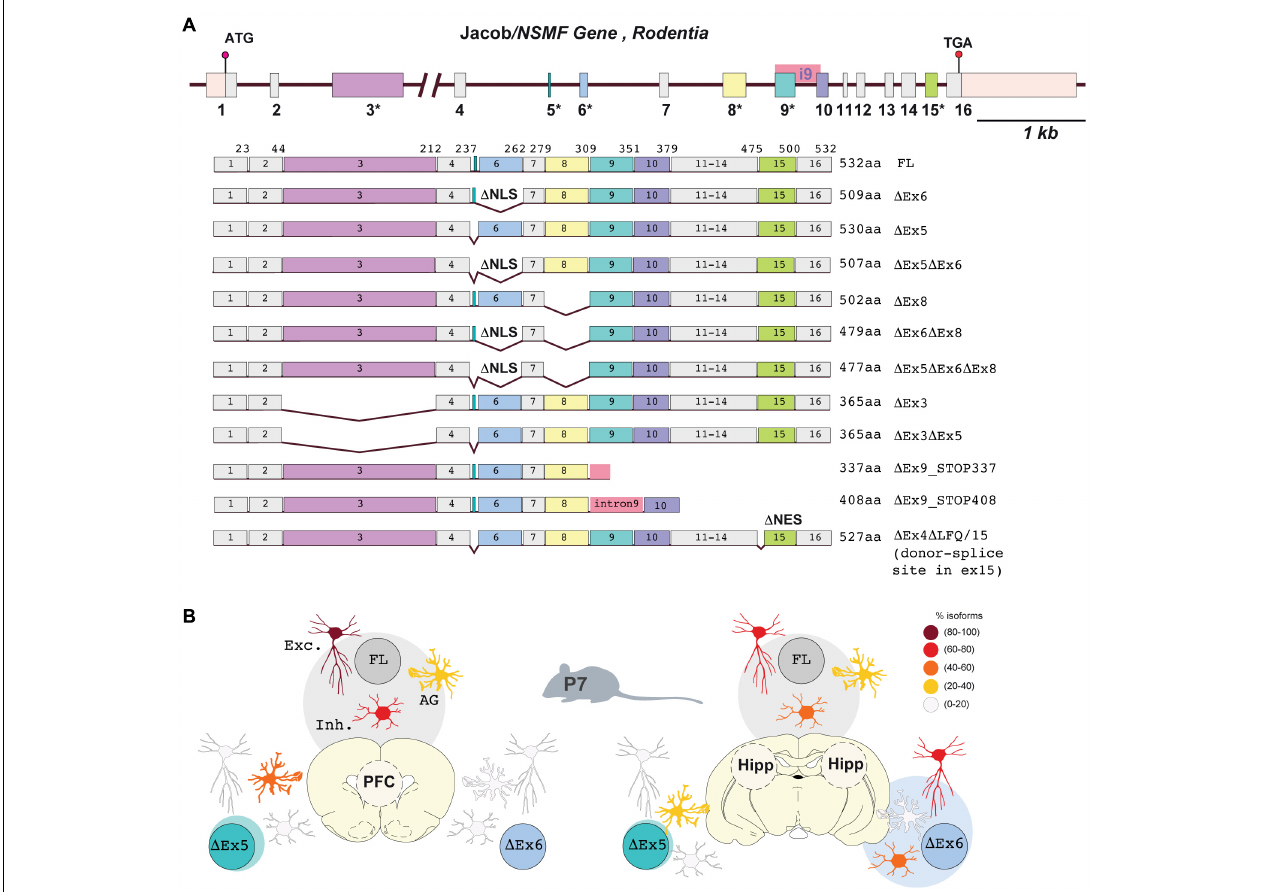
FIGURE 2 | Jacob /NSMF gene in rodents comprises 16 exons from which at least 5 are alternatively spliced. (A) Schematic representation of Jacob/ NSMF gene structure (modified from Spilker et al., 2016a) and experimentally confirmed alternatively spliced mRNA variants resulting in various protein isoforms. Numbers with an asterisk represents alternatively spliced exons. Exons that are not spliced are indicated in gray. Isoform name and its length in amino acids (aa) are indicated in the right panel. (B) Schematic representation of the cell type-specific relative expression pattern of Jacob/ NSMF splice variants based on single-cell isoform RNA sequencing and genePlot analysis. Indicated are excitatory neurons (Exc.), inhibitory neurons (Inh.) and astrocytic glia (AG). Color code from white-to-dark red indicates relative amounts of mRNA transcripts in the prefrontal cortex (PFC) and hippocampus (Hipp) in early development (P7 mouse brain). Shaded circles indicate the relative abundance of a particular isoform vs. others within the brain